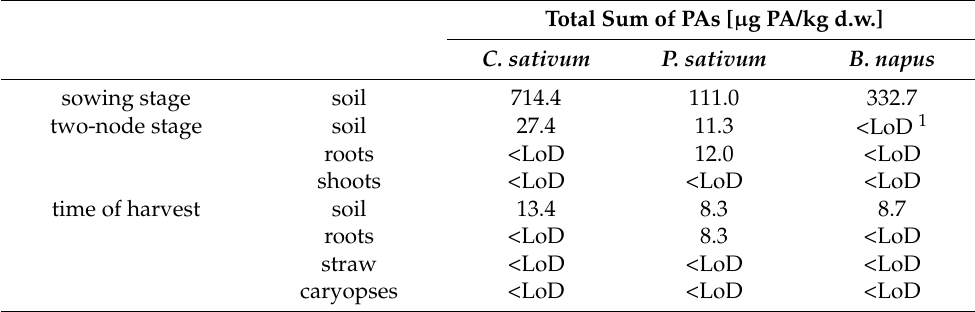
Table 4. PA-content of various follow-up crops on plots used for the cultivation of L. squarrosa the year before.